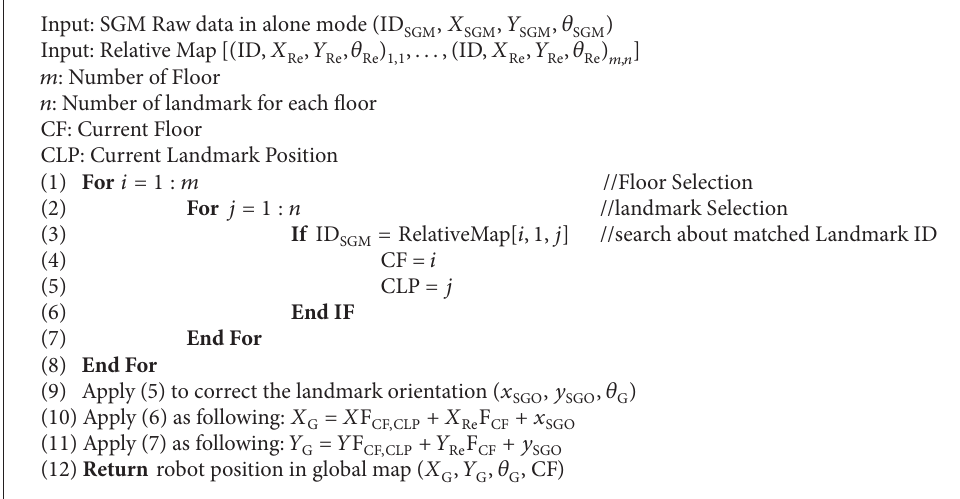
Algorithm 1: Localization method in multifloor